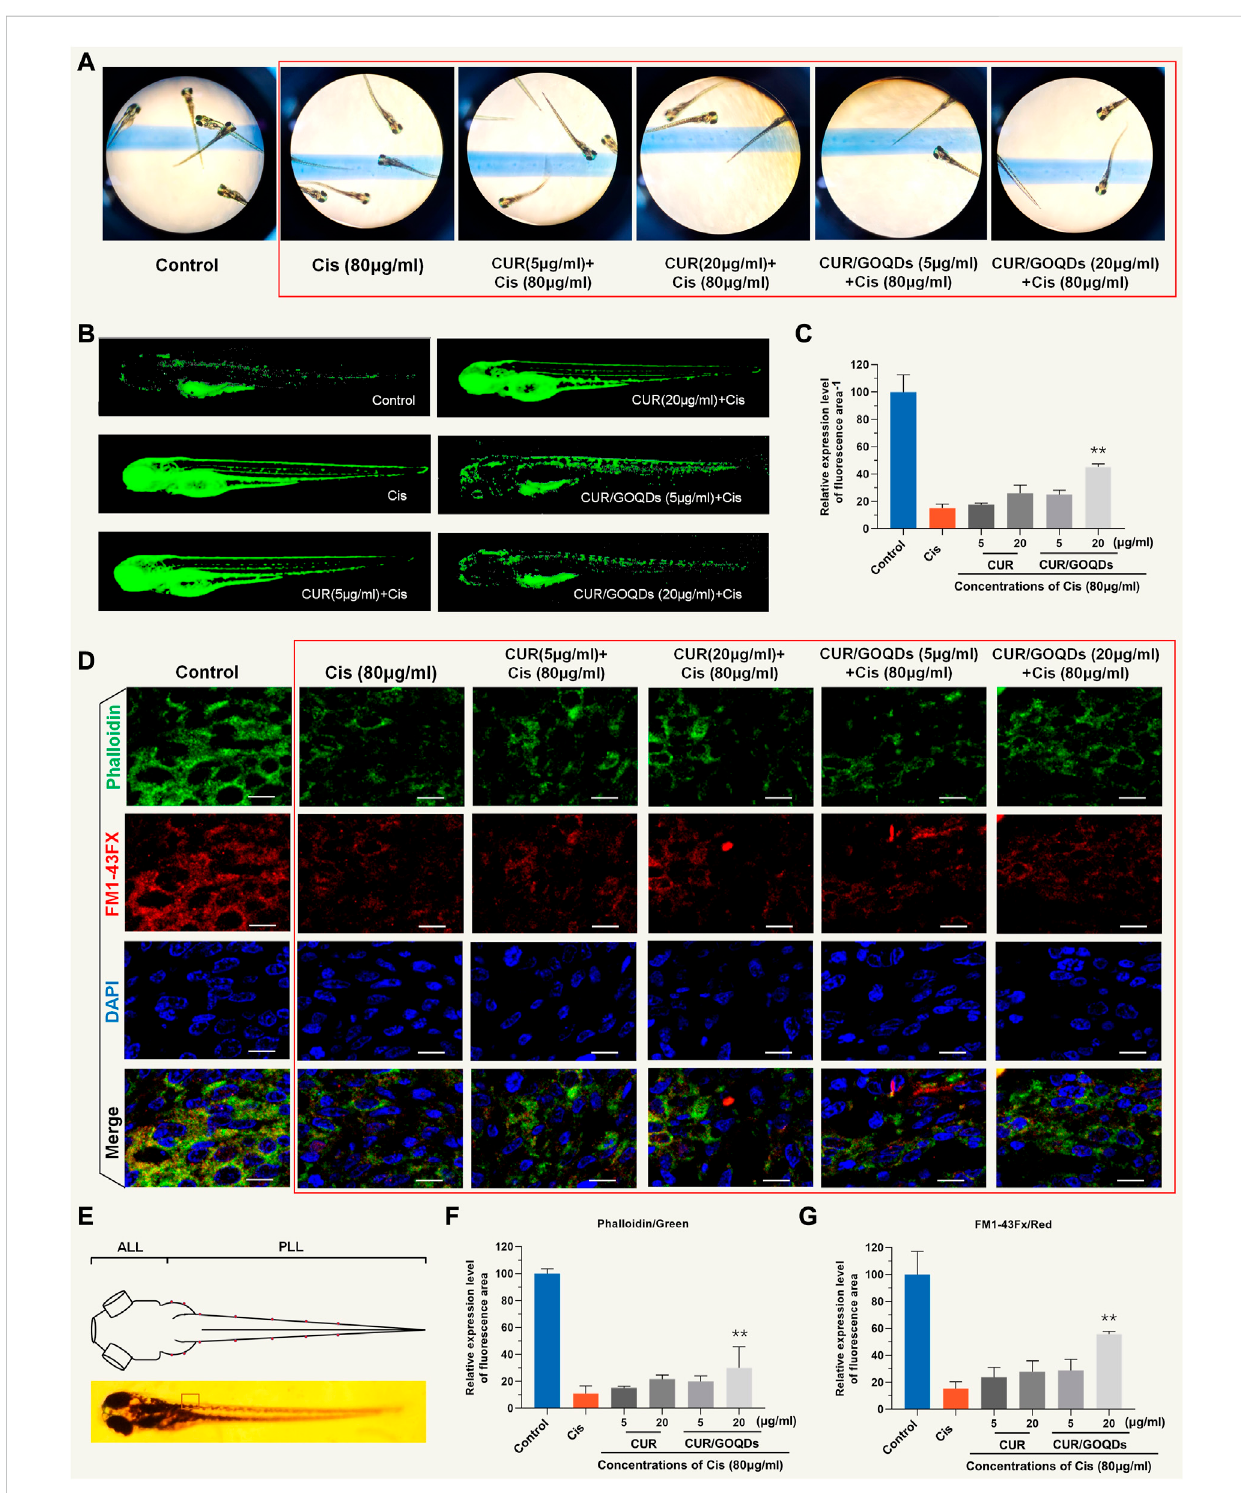
FIGURE 6 Evaluation of hair cells damage by DASEPI in zebra fi sh. (A – B) Zebra fi sh hair cells stained with DASEPI (green) showed the damage to CIS and the protective effectofCURorCUR/GOQDs. (C) Calculated thepercentageofprotectionofCUR orCUR/GOQDs.** p < 0.001. (D) Haircells, stereocilia, and nucleiwerestainedwithFM1-43FX(red),phalloidin(green),andDAPI(blue),respectively.Thedorsalviewofzebra fi shlarvaeshowsthedistributionofhair cells along the body (E) . Anterior lateral line (ALL) and posterior lateral line (PLL). (F – G) The number of hair cells of the zebra fi sh larvae decreased signi fi cantly treated with CIS. Scale bars = 10 μ